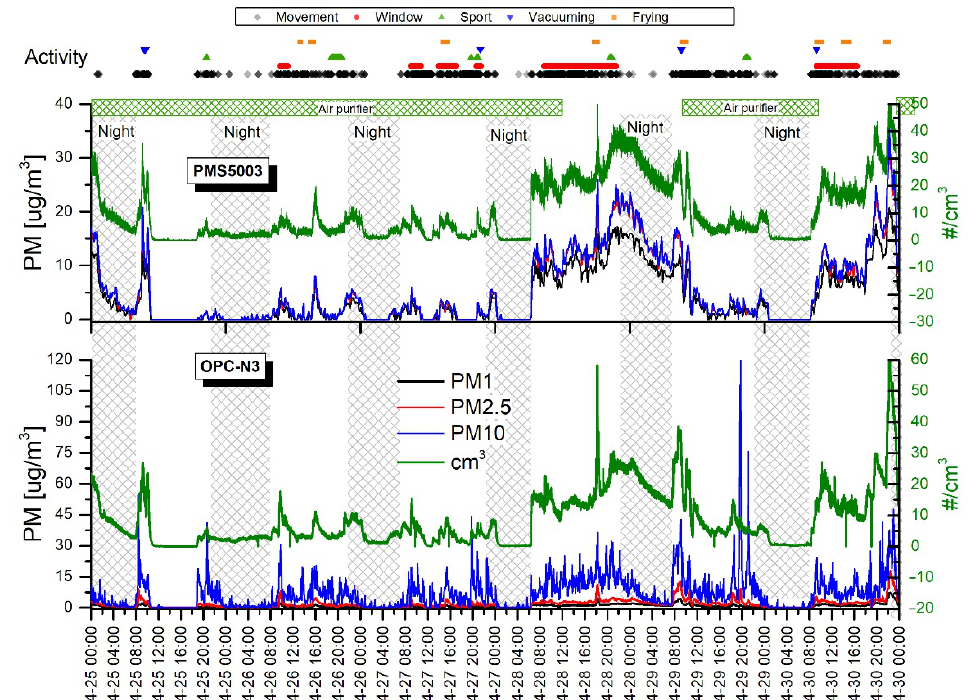
Figure 6. Variations in indoor mass concentrations of PM 1 , PM 2.5 , and PM 10 measured with the PMS5003 and OPC-N3 sensors for the first week. The green linear graph shows total particle counts for each sensor (right axis). The activity points on the top are common to both sensor graphs.